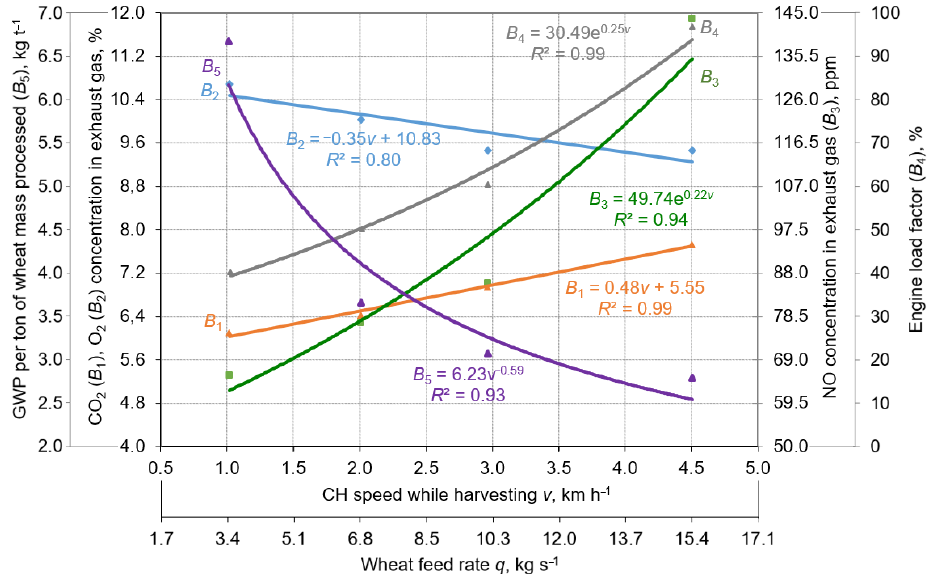
Figure 4. Relationships between combine harvester (CH) speed, wheat feed rate, engine load factor, global warming potential (GWP) per ton of wheat mass processed, and exhaust gas concentrations during threshing in the 2020 tests. The value of each point was obtained from an average of 20 replicates. These variations are attributed to the fact that, as the speed of the CH increases, the